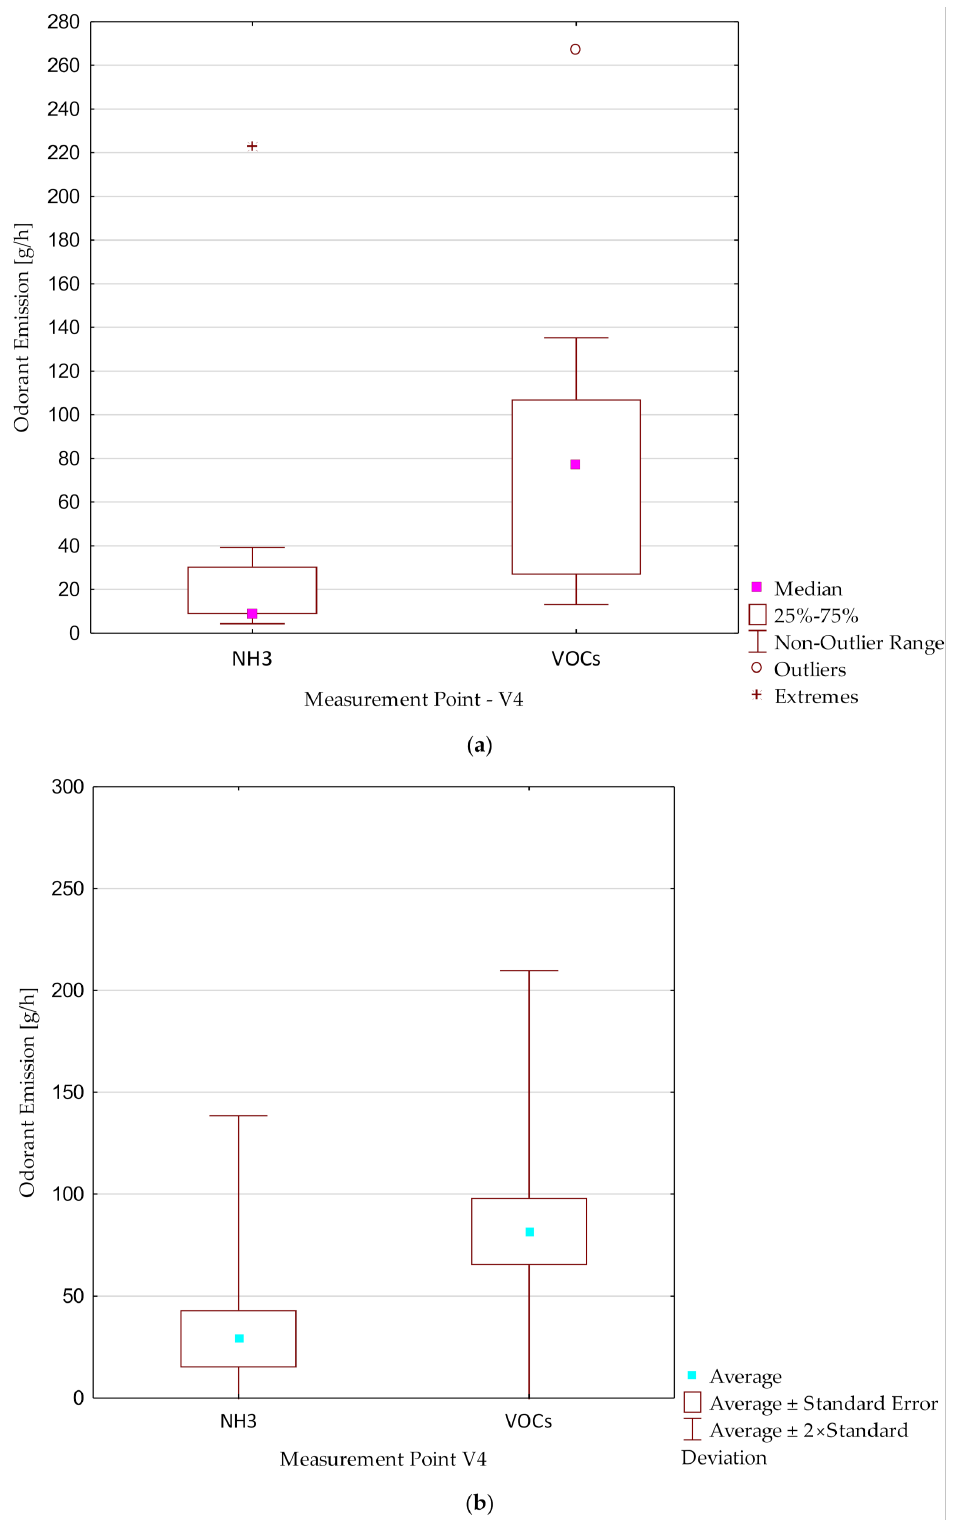
Figure 6. Odorant emission levels with median ( a ) and average ( b ) values at the fourth point (from the digestate dewatering hall) in every measurement